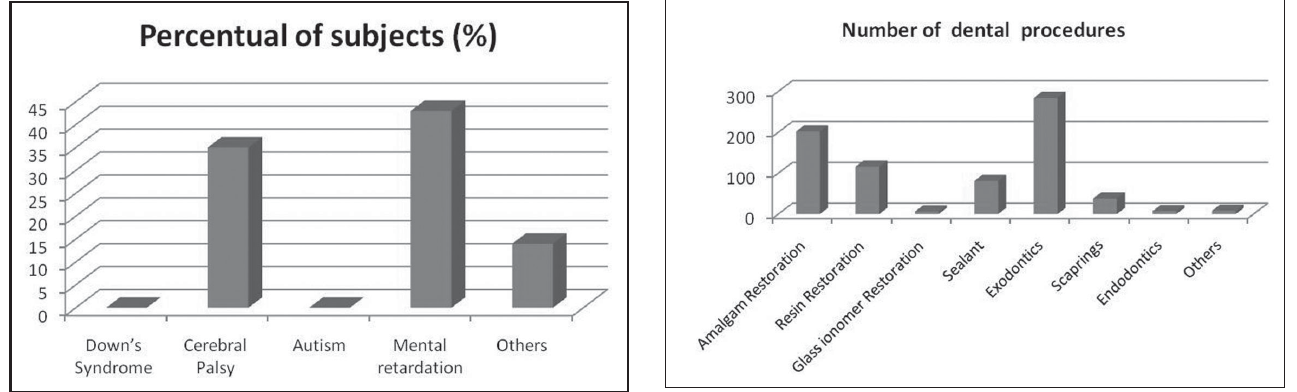
Fig. 1. Classification of patients according to the handicapping condition. Figure 2. Number of dental procedures performed under